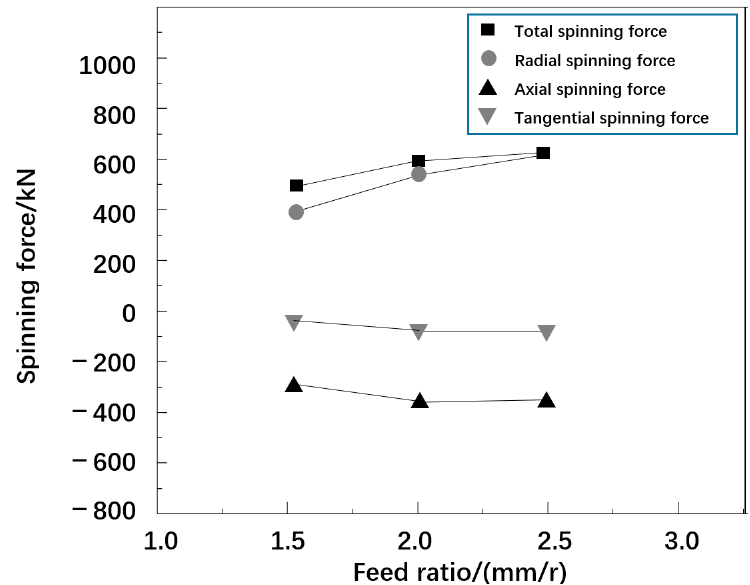
Figure 7. The variation curve of spinning force with the feed ratio. Table 3. The maximum and minimum wall thickness of cylinders after spinning at Feed ratio.